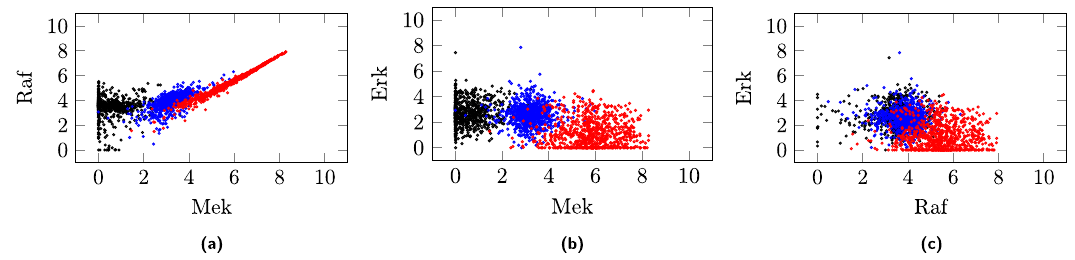
Figure 9: Scatter plots of the logarithms of active RAF, MEK, and ERK concentrations for the data in ref. [ 18 ] . The blue circles correspond to cells treated only with anti - CD3 and anti - CD28, which activate the signalling cascade. The red circles correspond to cells treated with anti - CD3, anti - CD28, and in addition, the MEK - activity inhibitor U0126. The inhibition of MEK results in an increase of MEK and RAF, whereas ERK is reduced. The black circles correspond to cells treated with β 2cAMP ( but not anti - CD3 and anti - CD28 ) , which seems to a ff ect MEK, but leaves RAF and ERK